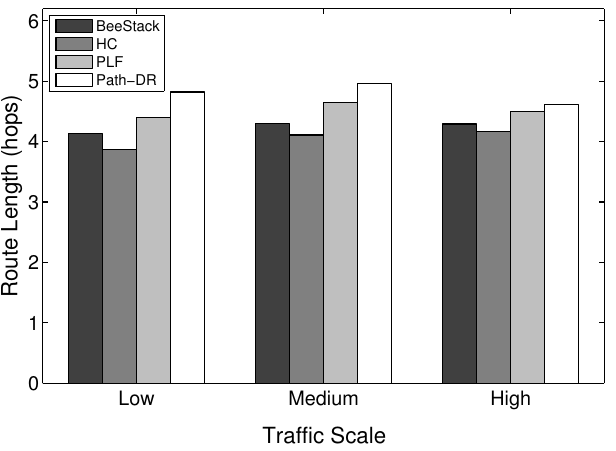
Average lengths of routes chosen by different routing metrics and traffic